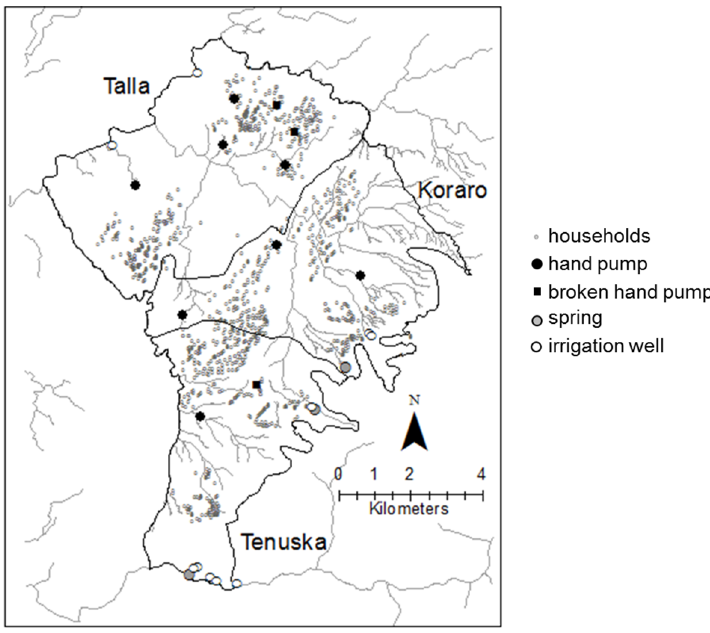
Figure 1. Water Sources in the Koraro Region including household locations (unpublished household data from the MVP baseline survey). Hand pumps are represented by the black icons (functioning hand pumps in black circles and broken pumps in squares), springs by grey circles, and irrigation wells in open circles. The smaller open circles represent the locations of households within the region.